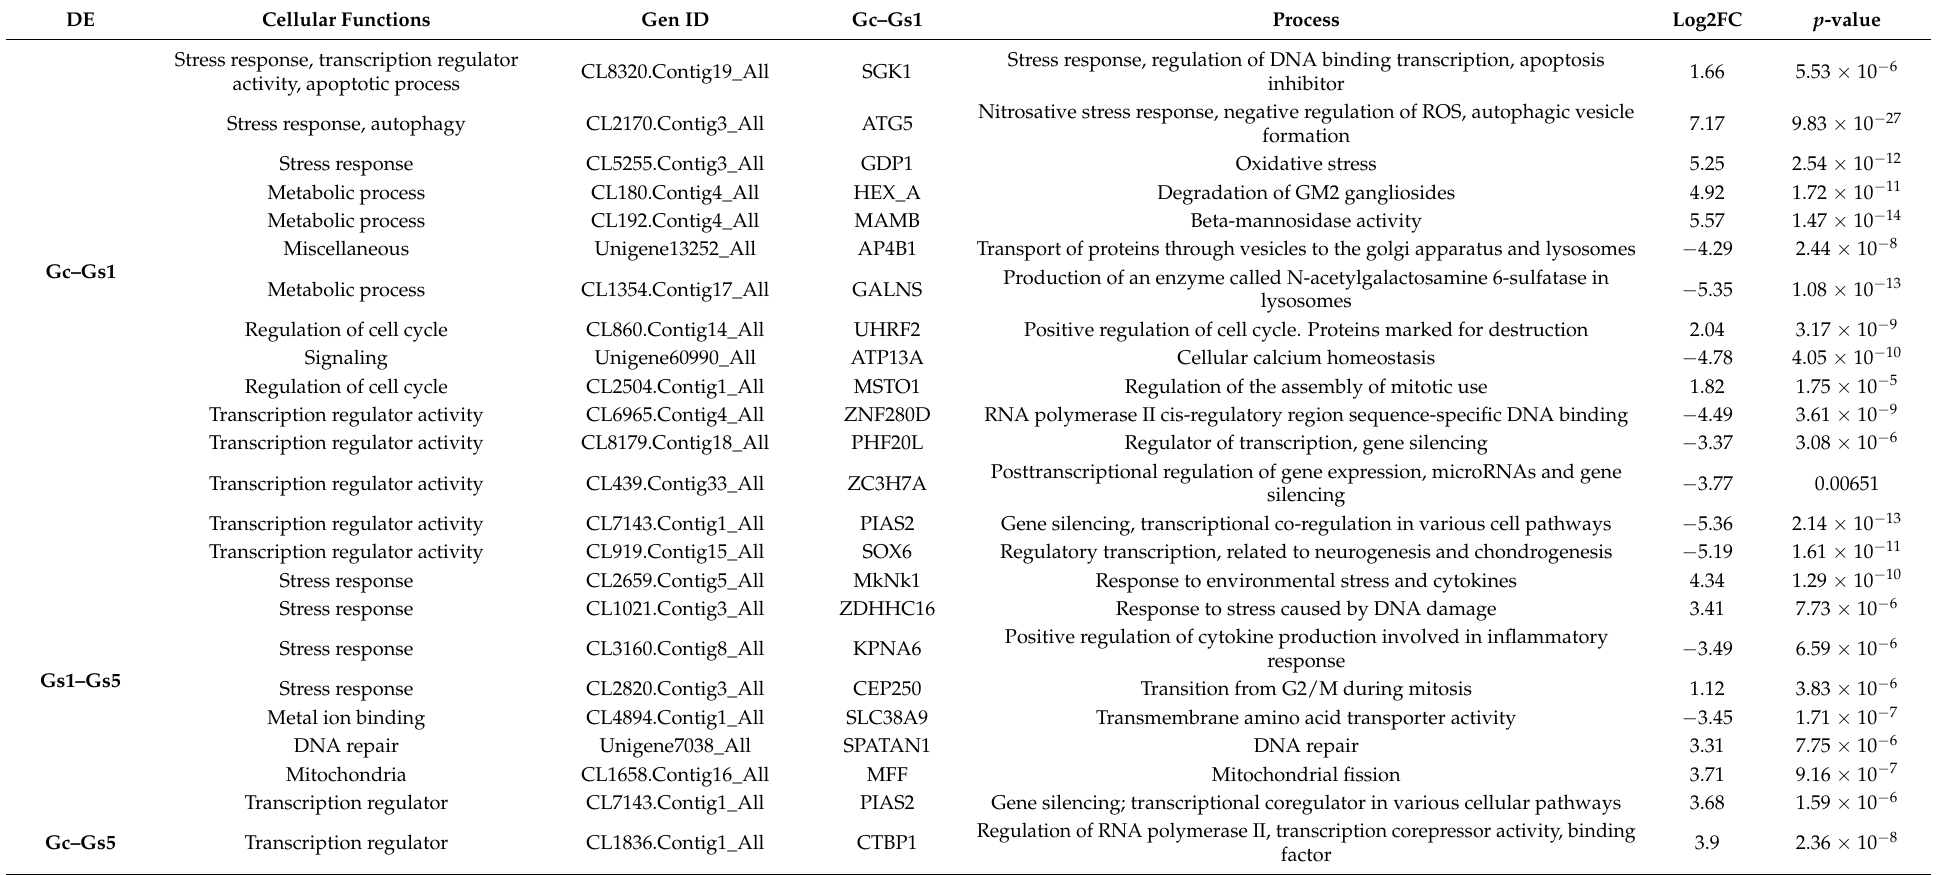
Table 3. Top 25 annotations for the gene ontology of differentially expressed unigenes in loggerhead turtle erythrocytes from the Gc–Gs1, Gs1–Gs5, and Gc–Gs5 comparisons. Upregulated genes ( ≥ 1 fold) and downregulated genes ( ≤− 1 fold, p -value < 0.01) are